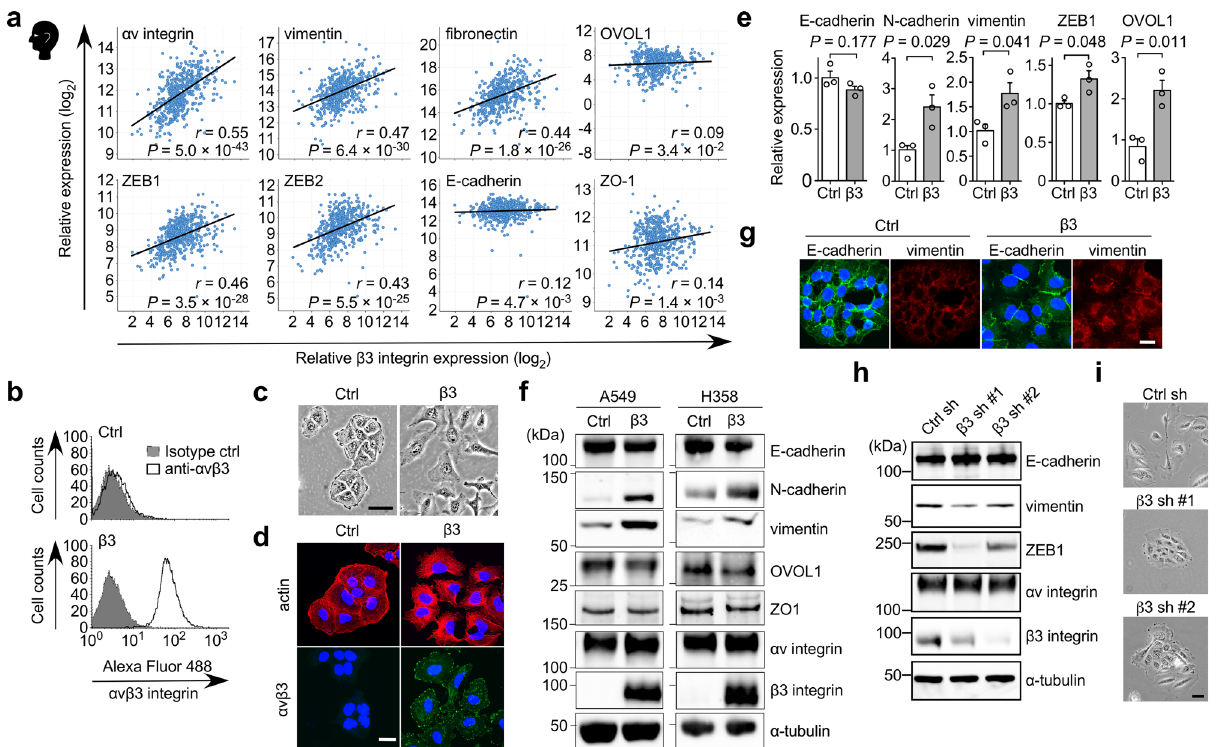
Fig. 2 Identi fi cation of α v β 3 integrin as a partial EMT inducer. a Correlation analysis between β 3 integrin and the indicated EMT-related gene expression levels in human lung adenocarcinoma tissues by RNA sequencing from TCGA dataset. Spearman ’ s rank correlation and P value are shown ( n = 517 patients). b FACS analysis of the cell surface expression of α v β 3 integrin in control and β 3 integrin expressing A549 cells. c Cell morphology of control and β 3-A549 cells. Scale bar, 50 µ m. d F-actin (red) and α v β 3 integrin (green) staining of control and β 3-A549 cells. Images are shown with nuclear stain (blue). Scale bar, 25 µ m. e Relative mRNA expression levels (qRT-PCR) of EMT markers in control and β 3-A549 cells. Two-tailed unpaired Student ’ s t -test, mean ± s.e.m., n = 3 independent experiments conducted in triplicate. The source data are provided in Supplementary Data 1. f Western blotting of EMT markers in control and β 3-A549 cells or control and β 3-H358 cells. g Immuno fl uorescence-based single cell analysis using anti-E-cadherin and vimentin antibodies in control and β 3-A549 cells. h Western blotting of EMT markers in H1975 cells expressing a control shRNA or two β 3 integrin-speci fi c shRNAs. i Cell morphology of H1975 cells expressing a control shRNA or two β 3 integrin-speci fi c shRNAs. Scale bar, 50 µ m. Unprocessed blot images in ( f and h ) are shown in Supplementary Figs. 3 –